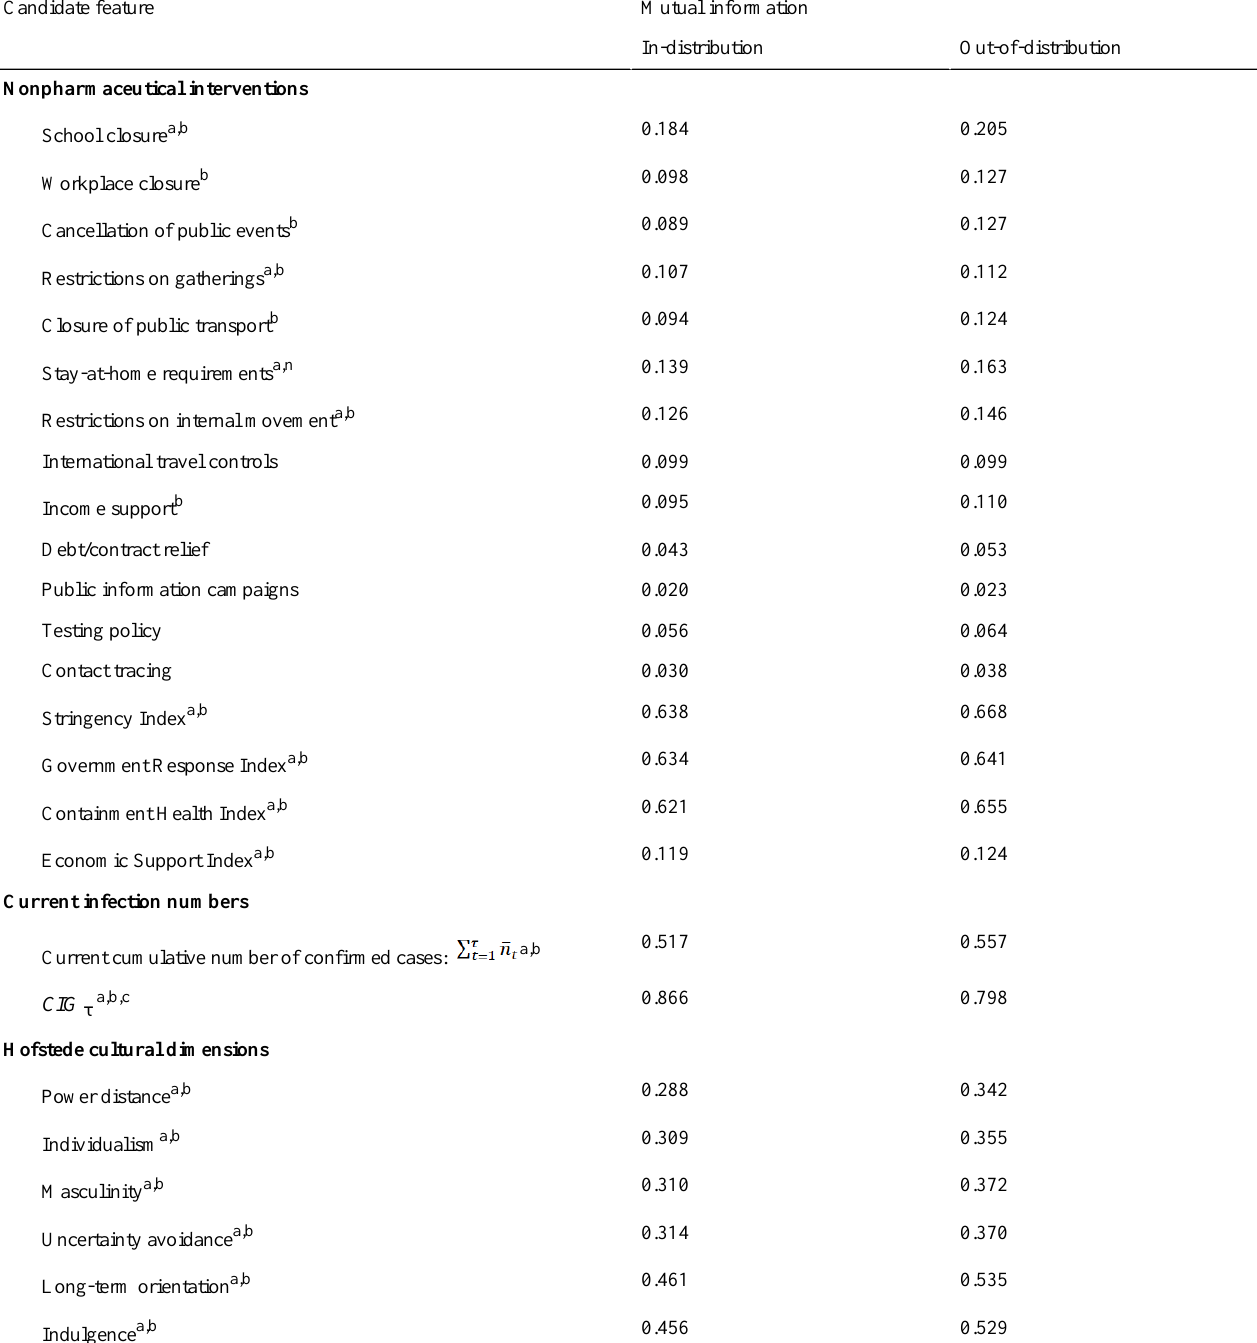
Table 2. Mutual information of candidate features for the in-distribution and out-of-distribution validation methods. In the cross-validation method, the 10 folds have varying mutual